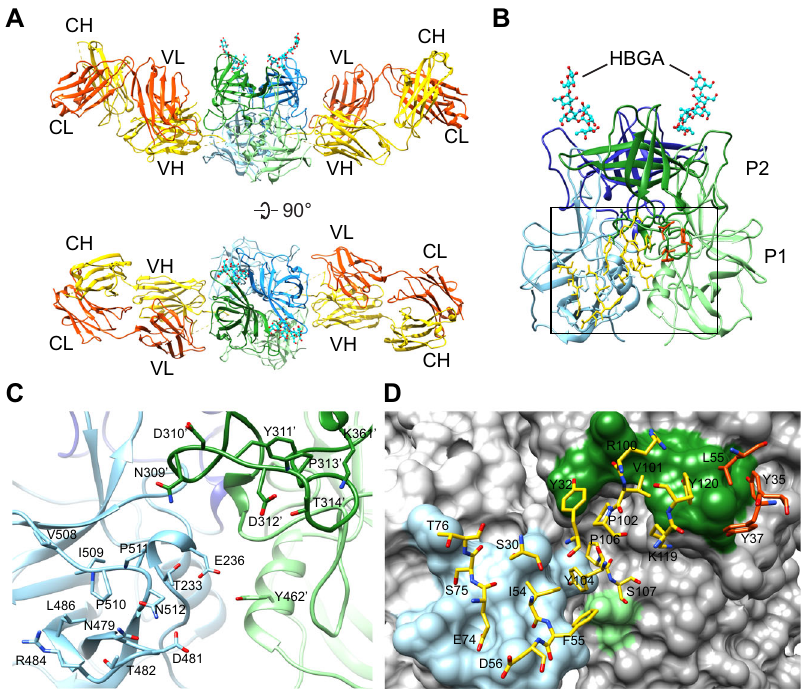
Fig. 6 NORO-320 Fab in complex with GII.4 P-domain. A X-ray crystal structure of the NORO-320-GII.4 P-domain complex. The two P-domain subunits in the dimer are colored in blue and green. NORO-320 Fab (yellow-heavy chain and red-light chain) along with two molecules of H-type 1 pentasaccharide (stick model) are modeled to indicate the glycan-binding sites for reference. Depicted are side and top views of the complex. B Side view of NORO-320 in complex with GII.4 P-domain showing the interacting Fab residues (stick model) with the light and heavy chain residues shown in red and yellow, respectively, interacting. C Close-up view of the Fab binding site (black box in B) showing the P-domain residues (stick models) that interact with the Fab. Residues in the two-fold related subunit (green) are hyphenated. D Close-up view of the Fab residues (light chain-red, heavy chain yellow) that interact with the GII.4 P-domain (shown in surface